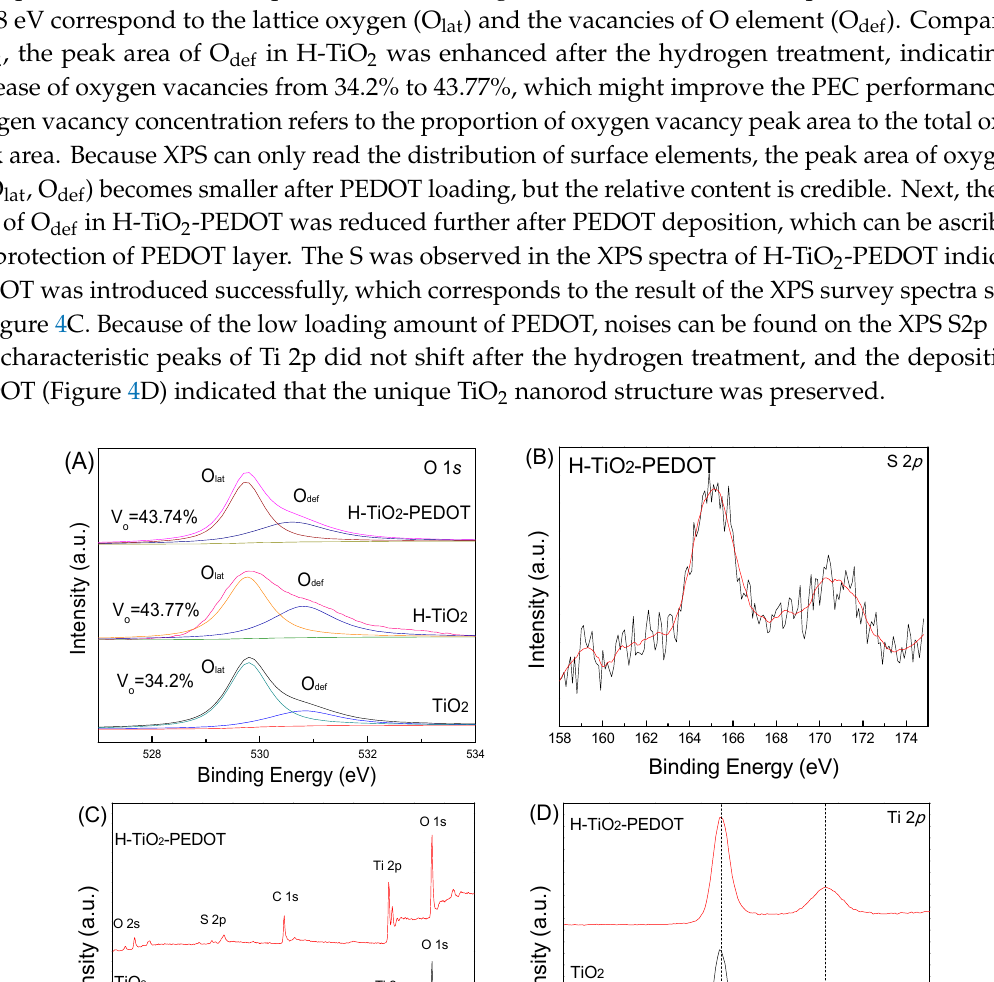
Figure 3. EDS mapping of H-TiO 2 -PEDOT. ( A ) Scanning area, ( B ) O Element, ( C ) C Element, ( D ) Ti Element, ( E ) Sn Element, ( F ) S Element.